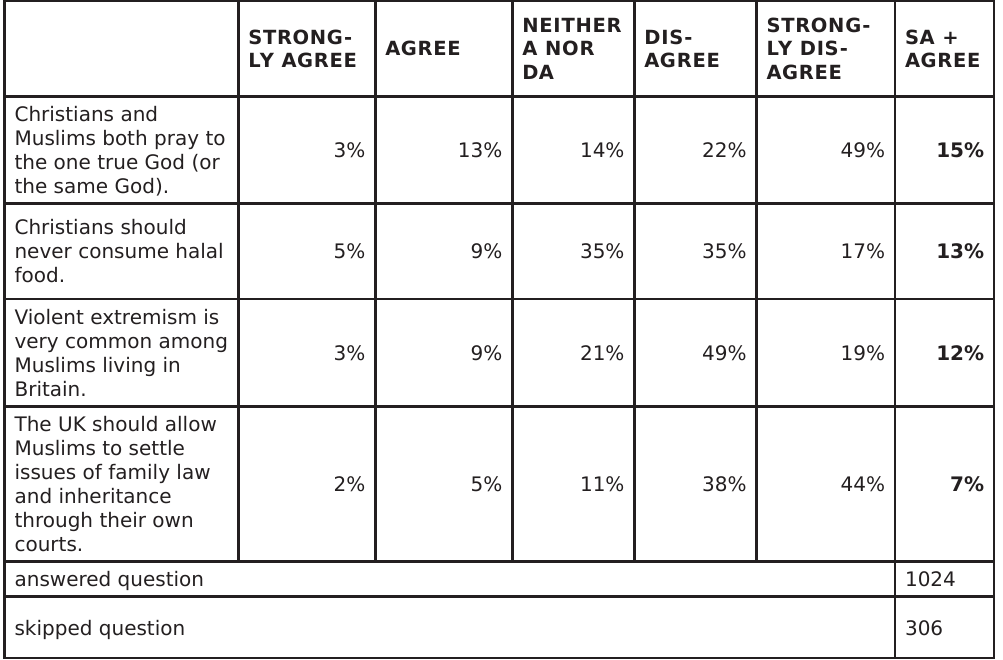
Evangelicals’ attitudes towards Islam and